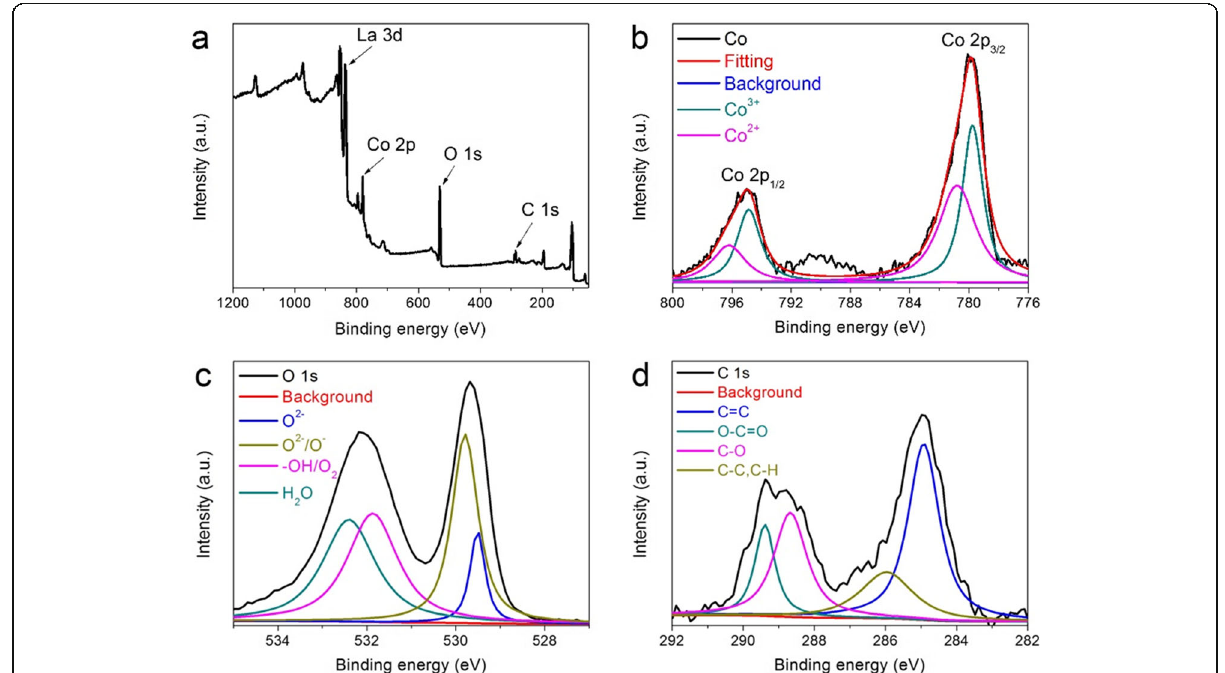
Fig. 6 a XPS survey scan of rGO@LCO surface, and high-resolution spectrum of b Co 2p, c O 1s, and d C